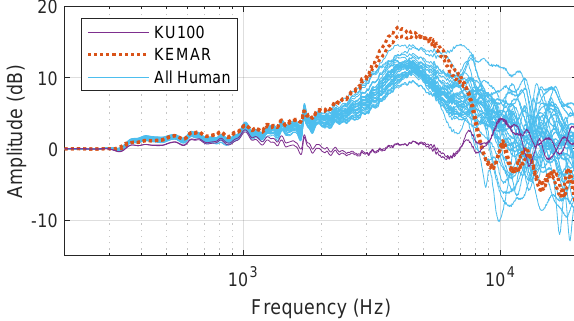
Figure 4. The diffuse field response of each ear of each subject (total 40 responses) after free field equalisation of both the average loudspeaker and respective binaural microphone responses. The responses of the KEMAR and KU100 dummy heads are distinguished from the other human responses. The plot shows a common broad peak at approximately 4KHz which may be explained by ear canal